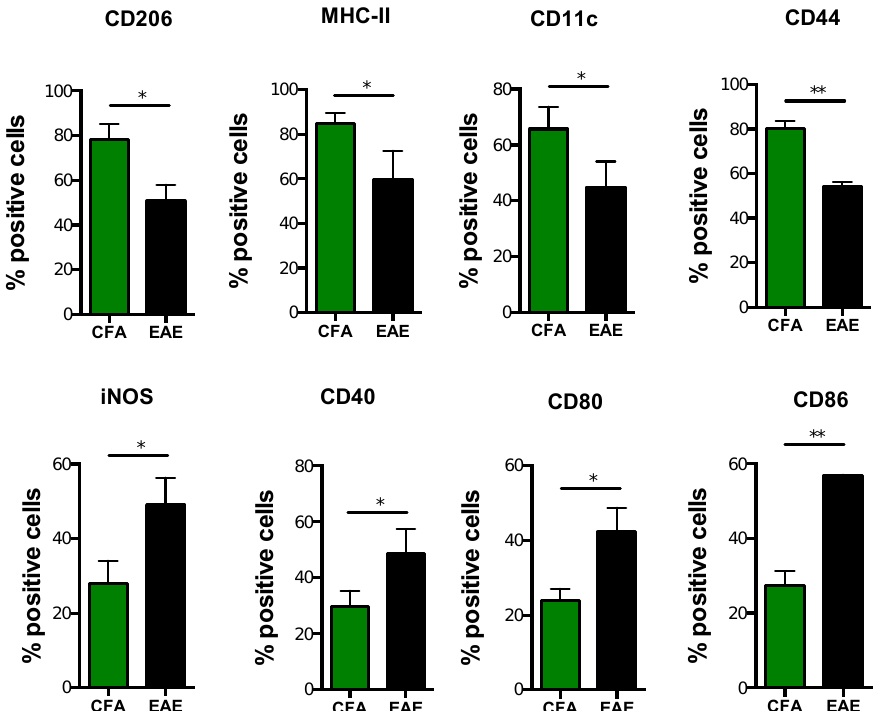
Figure 5. Immunophenotype of M2 macrophages obtained from CFA and EAE mice. Monocytes obtained from spleen of CFA and EAE mice were differentiated into macrophages using M-CSF (50 ng/mL) for 6 days and then polarized into M2 with IL-4 (20 ng/mL) for 2 more days. Expression of markers by flow cytometry upon staining cells at cell surface (CD40, MHC-II, CD80, CD86, CD206, CD11c, and CD44) or intracellularly (iNOS). Data are reported as percentage of positive cells and are representative of eight independent experiments ± SEM. * p < 0.05, ** p < 0.01.